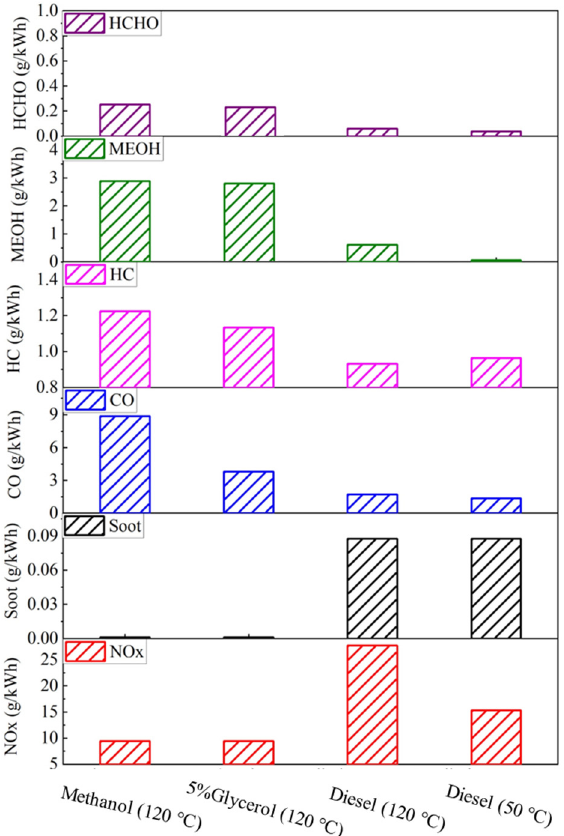
Figure 9. Combustion exhaust pollutant emissions of different fuels.